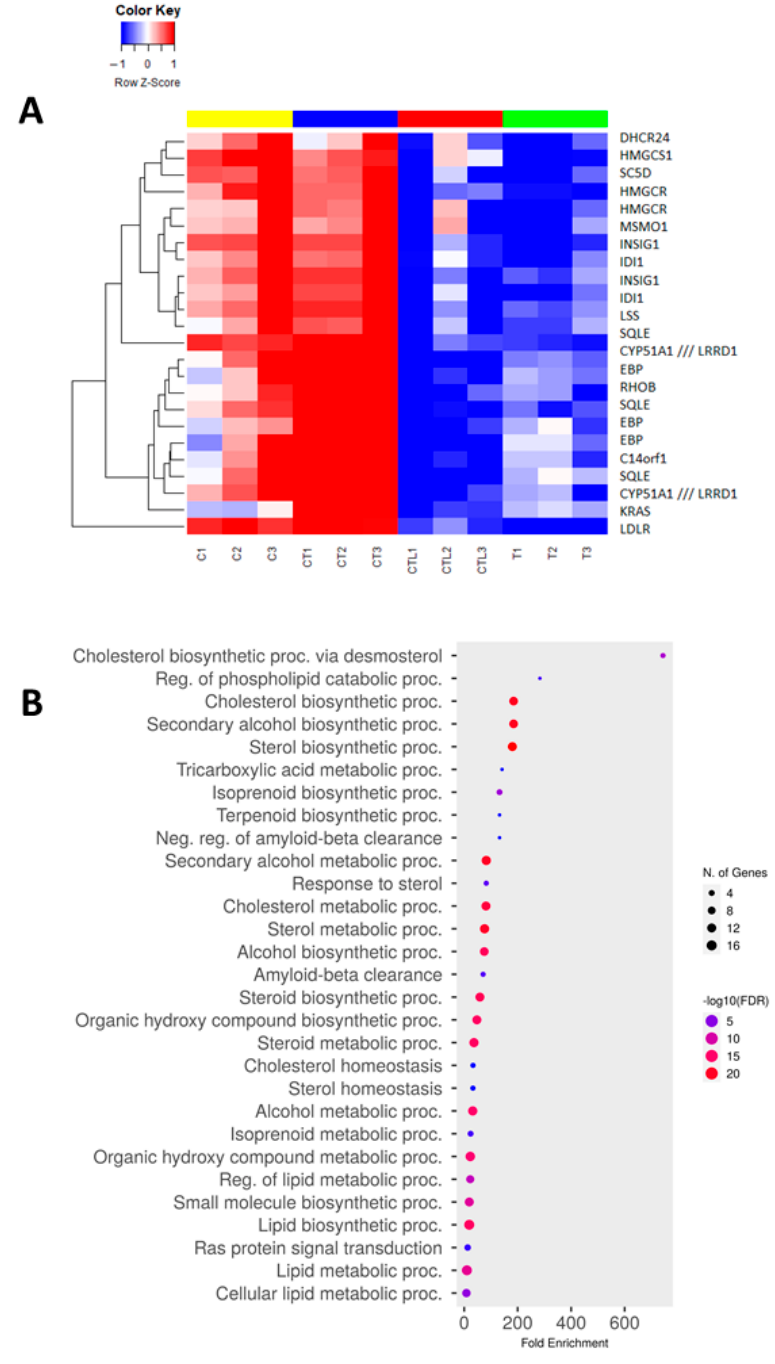
Figure 5. Expression profiles of UPMM3 cells treated with the combination of trametinib (10 nM) and cerivastatin (0.125 µM) versus trametinib, for 24 h. A : The expression profiles were interrogated by significance analysis of micro-arrays and the expression values of significantly differentially ex- pressed genes were clustered by hierarchical clustering. The expression values are reported by a colour scale (blue = expression below the mean, red = expression above the mean, white = expression at the mean; the intensity is related to the distance from the mean). The bars above the dendrogram show the treatment status (cerivastatin = yellow, untreated = red, trametinib = green, and trametinib and cerivastatin treatment = blue). B : Gene set enrichment analysis for statistically significant GO biological process related to the above identified differentially expressed genes. The X-axis label